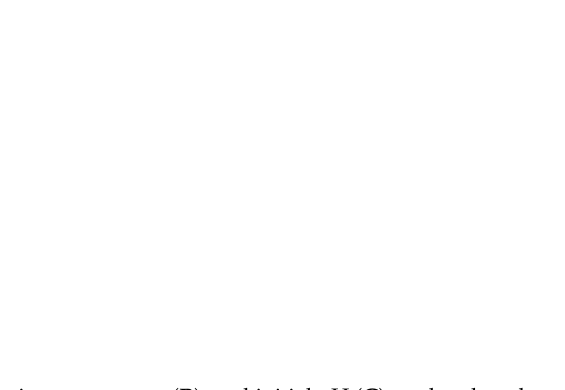
Figure 4. Effect of different carbon ( A ) and nitrogen sources ( B ), and initial pH ( C ) on the phosphate- solubilizing capacity of fungal isolate L4. Different lowercase letters indicate significant ( p < 0.05) difference between treatments.